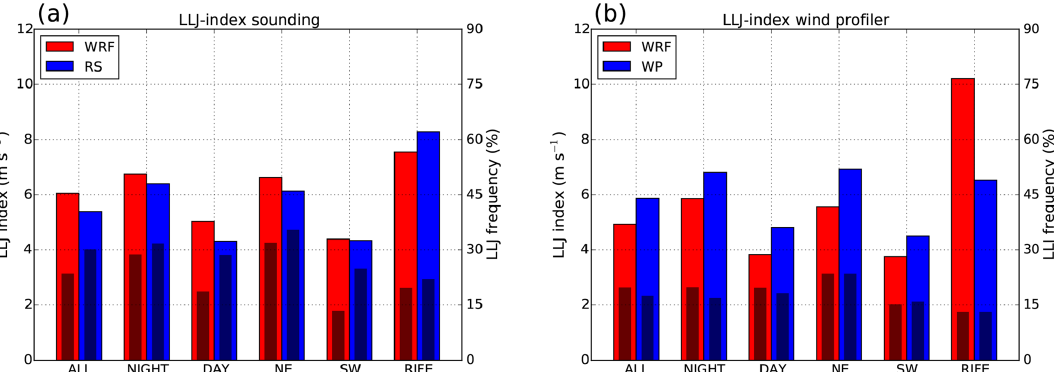
Figure 12. LLJ indices obtained from (a) RS launches and (b) WP measurements during the campaign. WRF D3 indices were obtained by interpolating data in space and time on the radiosonde flight track and on the wind profiler location. Indices were averaged over the whole campaign period (ALL), the night- and daytime (NIGHT, DAY) and for cases with wind directions from the NE (negative) and SW (positive cross-valley winds at 300ma.g.l.). The nocturnal index according to the computation of Rife et al. (2010) is labelled with RIFE. The black bars indicate the frequency of LLJ occurrence during all, night-/daytime and NE/SW cases, respectively. For RIFE, the black bars indicate the occurrence of nocturnal jets during the whole campaign. See Fig. 1 for the wind profiler location and the launch site for soundings (every